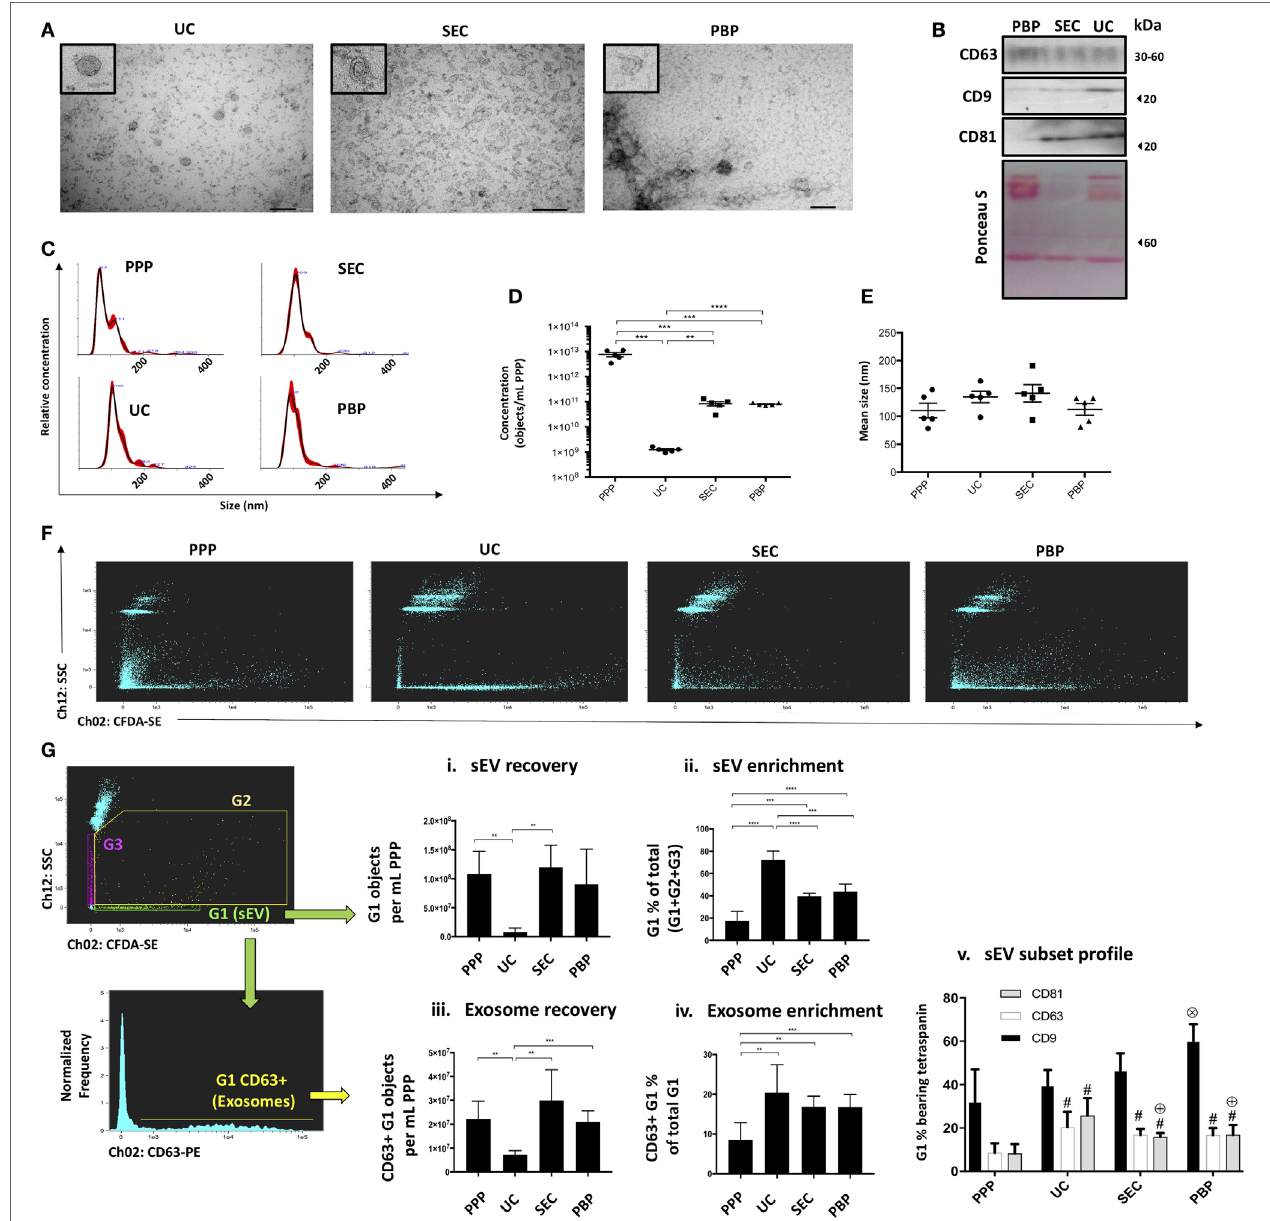
FIgURe 2 | Extracellular vesicle subtype analysis and the impact of exosome isolation technique (Application 1). Confirmation of the presence of exosomes in “small EV” (sEV) isolates from three commonly used isolation techniques (UC, ultracentrifugation; SEC, size-exclusion chromatography; PBP, polymer-based precipitation) was achieved using three methods. (A) Transmission electron microscopy images showing characteristic morphologic features of exosomes (size bars: 200 nm). Single extracellular vesicles (EVs) are shown in expanded (zoomed) box in top left of each image. (B) Western blot showing canonical exosomal markers, such as CD9, CD63, and CD81. (C–e) Nanoparticle tracking analysis (NTA) profiling of isolates and of platelet poor plasma (PPP) showing size distribution and concentration profiles given “per mL of starting PPP” following correction for dilution/concentration steps were performed. (F) ISx dot-plot showing Scatter and CFDA-SE intensity for all methods of isolation. (g) ISx analysis of sEV subset recovery, including bona fide, CD63-positive, and exosomes. (i) sEV recovery is estimated by applying the objects per mL statistical feature in IDEAS ™ to the G1 gate. (ii) The proportion of sEVs (G1) in relation to non-speed-bead events (G2 + G3) is used as an indication of sEV enrichment achieved by UC, SEC, and polymer-based precipitation (PBP) and compared to PPP. (iii) Exosome recovery is estimated by applying the objects per mL statistical feature in IDEAS ™ to the CD63 + events within the G1 gate. In the cases of UC, SEC, and PBP, objects per mL relate to starting PPP sample, which is to say that the raw readout from the ISx “objects per mL” feature is corrected for any dilution/concentration steps performed. (iv) The proportion of exosomes (G1-gated CD63 + events) in relation to non-speed-bead events (G2 + G3) is used as an indication of exosome-specific enrichment achieved by UC, SEC, and PBP and compared to PPP. (v) Profiling of other canonical exosome markers CD9 and CD81, in comparison to bona fide exosome marker CD63. For consistency, representative data and images in panels (A–C,F) are from a single healthy volunteer, with panel (g) representative plots being UC-derived. Data represented as mean ± SEM of five healthy volunteers. * P < 0.05, ** P < 0.01, *** P < 0.001, and **** P < 0.0001. # P < 0.05 relative to PPP. ⊕ P < 0.05 relative to UC. ⊗ P < 0.05 relative to PPP, UC, and